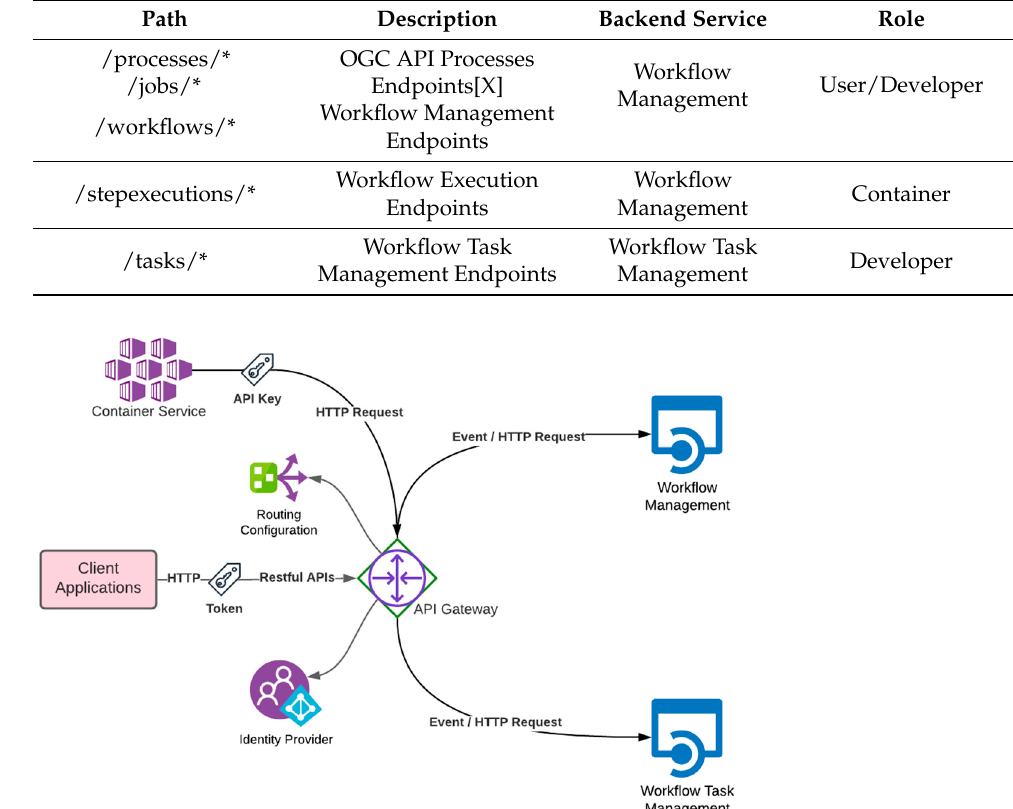
Table 3. API gateway rule table for routing.